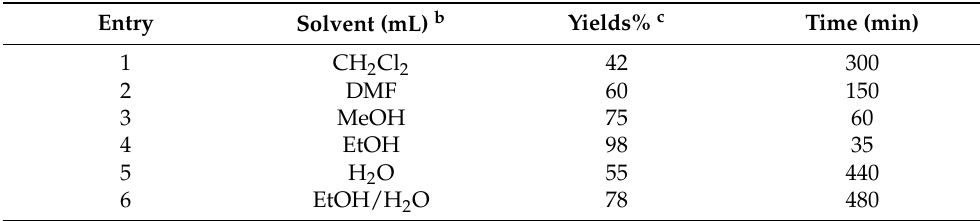
Table 4. Model compound synthesized with different solvents using 100 mg of 50% Al 2 O 3 catalyst under solar heat a .